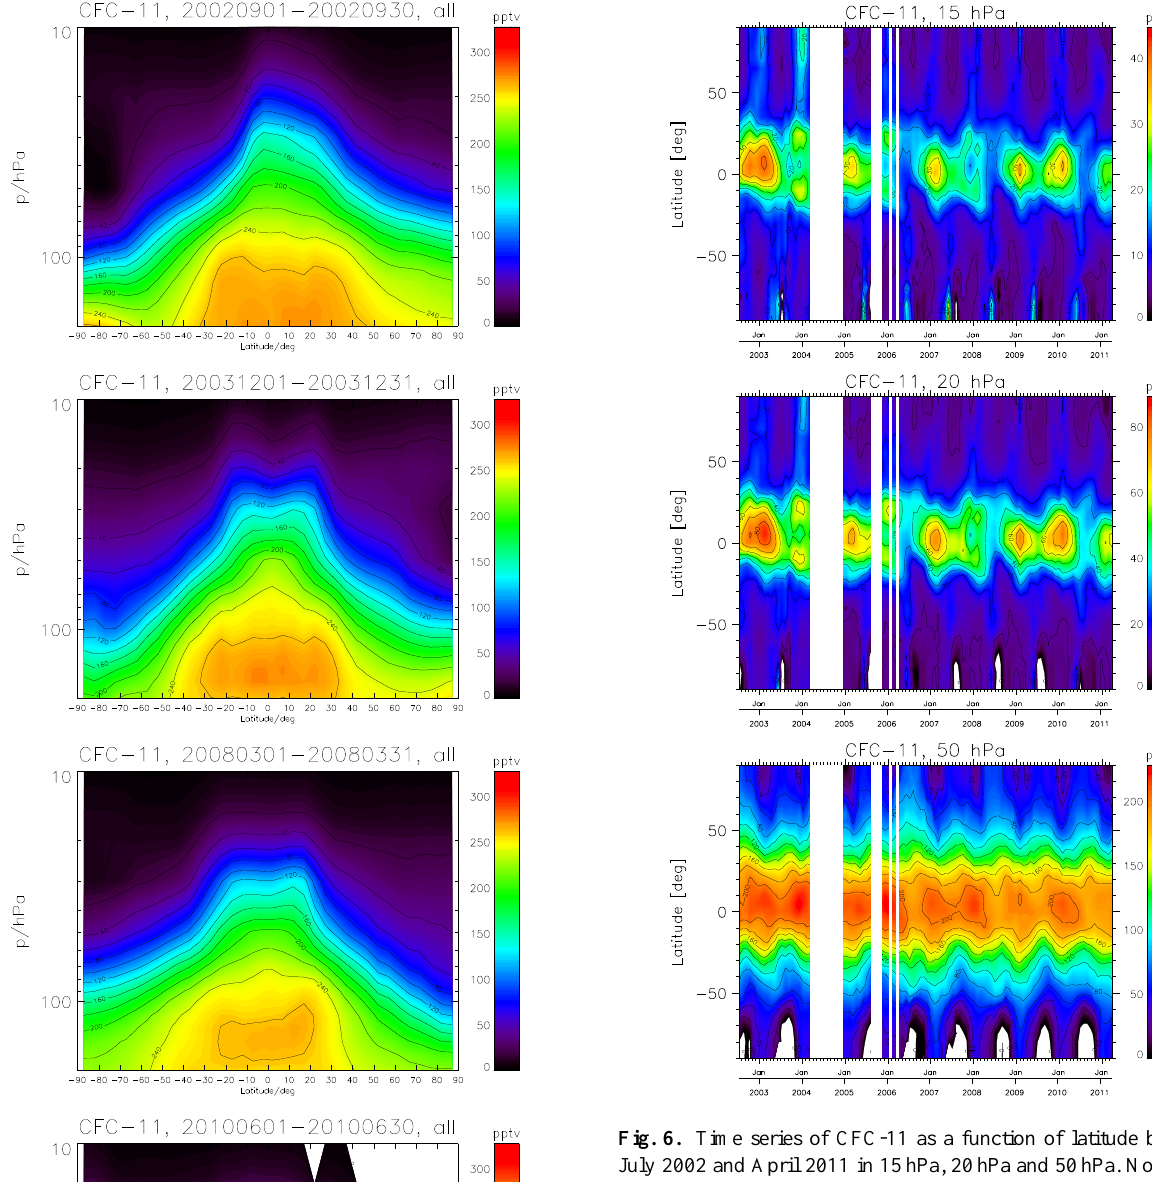
Fig. 4. Typical measured (black) and calculated (in red) spectra of CFC-12 and the fit residual in 11 km in the 915.0–925.0 cm − 1 spec- tral region for the FR (top) and the RR (bottom) spectral resolution nominal modes.